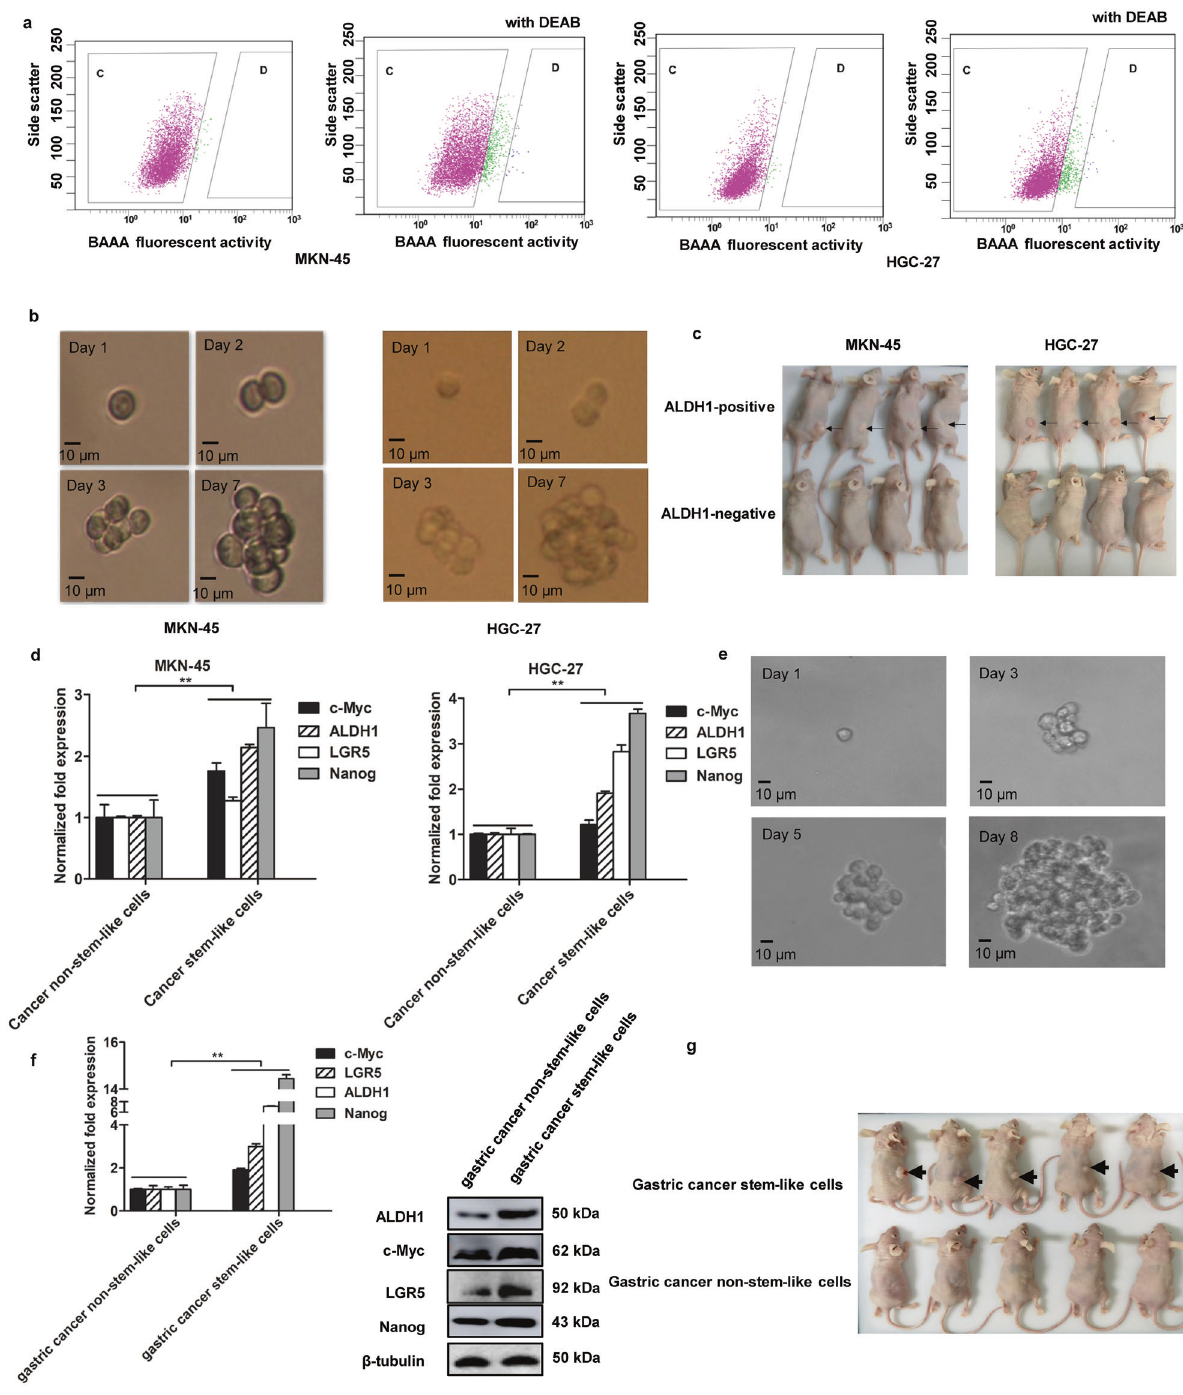
Fig. 1 Sorting of gastric cancer stem-like cells. a Sorting of gastric cancer stem-like cells. The fl uorescence activated cell sorting was performed based on the detection of ALDH1 activity using the ALDH1 fl uorescent substrate BODIPY-aminoacate (BAAA). As a control, the activity of ALDH1 was inhibited by DEAB. The ALDH1-positive cells were potential gastric cancer stem-like cells (D region) and ALDH1- negative cells were cancer non-stem-like cells (C region). b Tumorsphere formation assay. The ALDH1-positive cells were subjected to tumorsphere formation assay. The sphere formation was examined with a light microscope. Scale bar, 100 μ m. c Tumorigenicity of cancer stem-like cells in nude mice. Mice were subcutaneously injected with ALDH1-positive or ALDH1-negative cells. Forty days later, the tumors were examined. Arrows indicate the tumors. d Differential expressions of stemness-associated genes in gastric cancer stem-like cells and non- stem-like cells. Quantitative real-time PCR was conducted to detect the mRNA levels ( ** p < 0.01). e Tumorsphere formation of gastric cancer stem-like cells from the solid tumors of patients with gastric cancer. Scale bar, 10 μ m. f The expression levels of stemness genes in gastric cancer stem-like cells isolated from the solid tumors of gastric cancer patients. The statistical signi fi cance of difference between treatments was indicated with asterisks ( ** p < 0.01). g Tumorigenicity of the potential gastric cancer stem-like cells in mice. Nude mice were subcutaneously injected with the potential gastric cancer stem-like cells or gastric cancer non-stem-like cells. Forty days later, the tumors were examined. Arrows indicate the